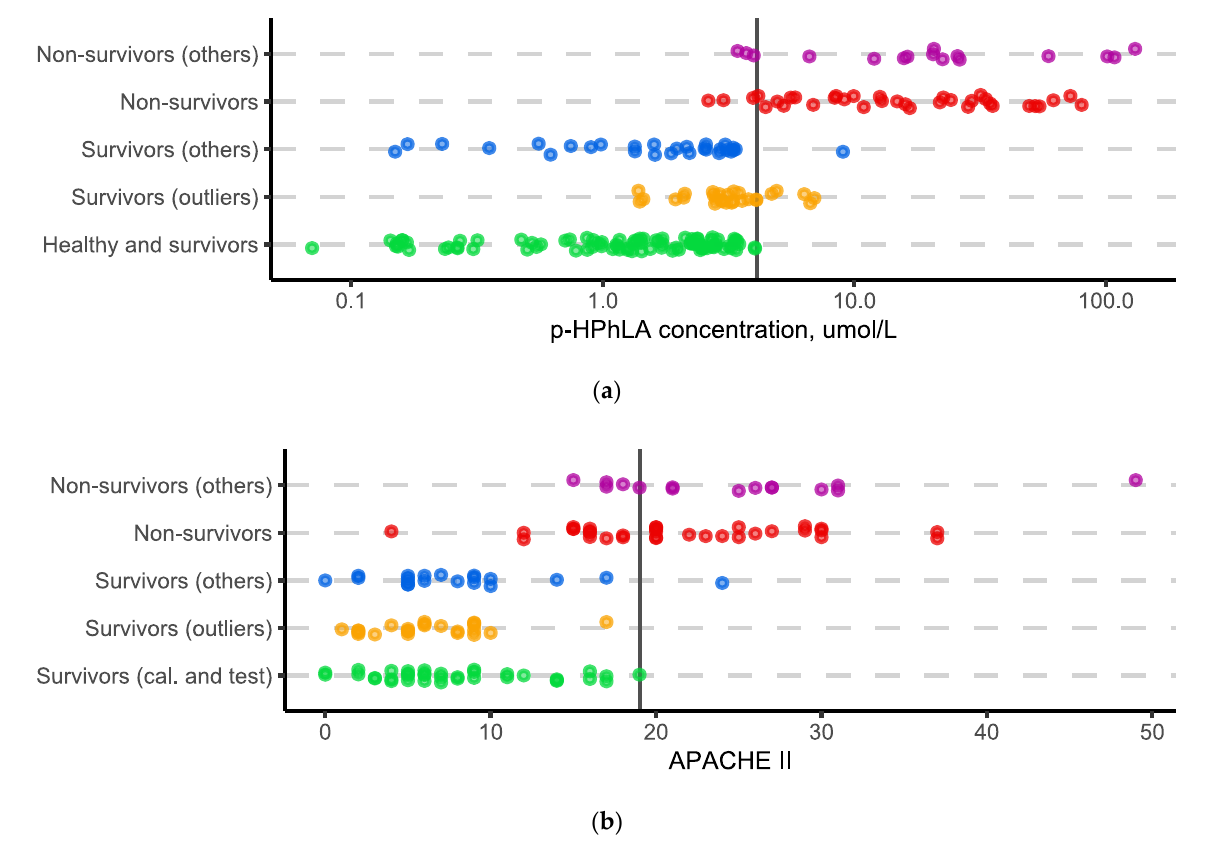
Figure 2. Visualization of the results obtained using the univariate models based on the concentration of the only p -HPhLA ( a ) and clinical APACHE II scale ( b ). The vertical line is the decision rule corresponding to the p -HPhLA concentration of 4.1 µmol/L or to the APACHE II score of 19 points. Points are scattered along the y-axis to improve perception in the case of overlapping.